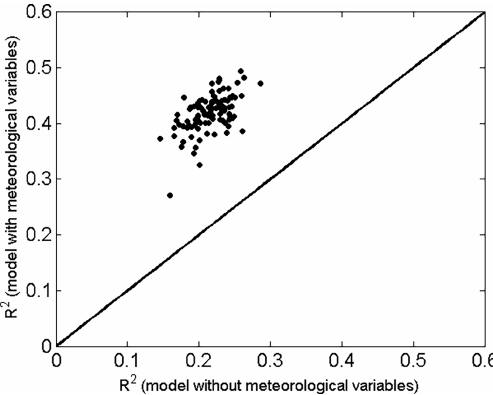
Figure 3. Same as Fig. 1 but just for cases during nighttime